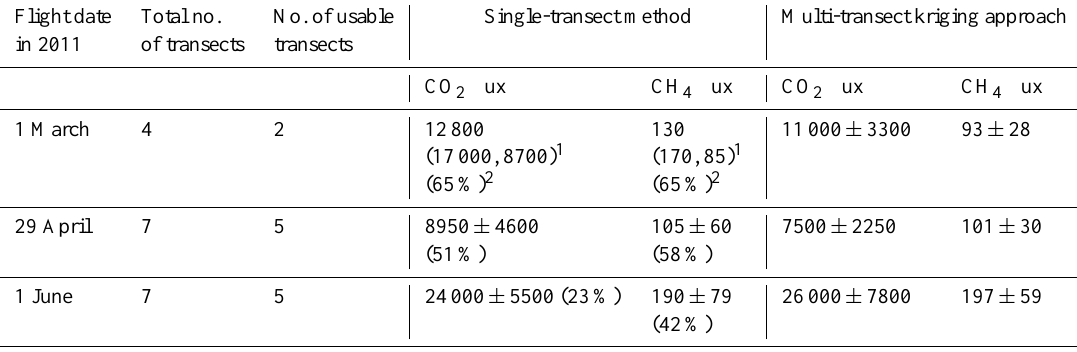
Table 4. Citywide CO 2 and CH 4 emission fluxes (mols − 1 ) derived from the single-transect method (mean ± 1s) and via the multi-transect kriging approach for the three flight dates in 2011. Percentage values in parentheses represent the relative standard deviation. The stated precision in the multi-transect kriging approach is 30%, with the average precision obtained from the multiple downwind experiments (Table